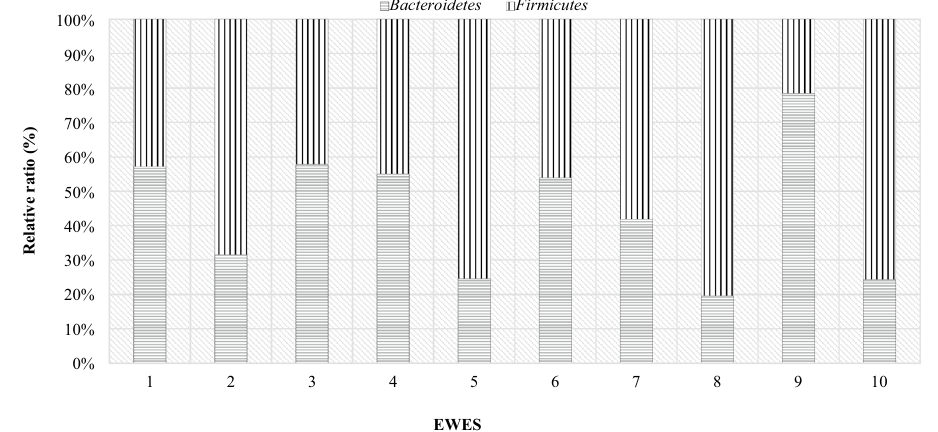
Figure 12. Relative ratio (%) of Firmicutes and Bacteroidetes phylum on the day 0 in ewes